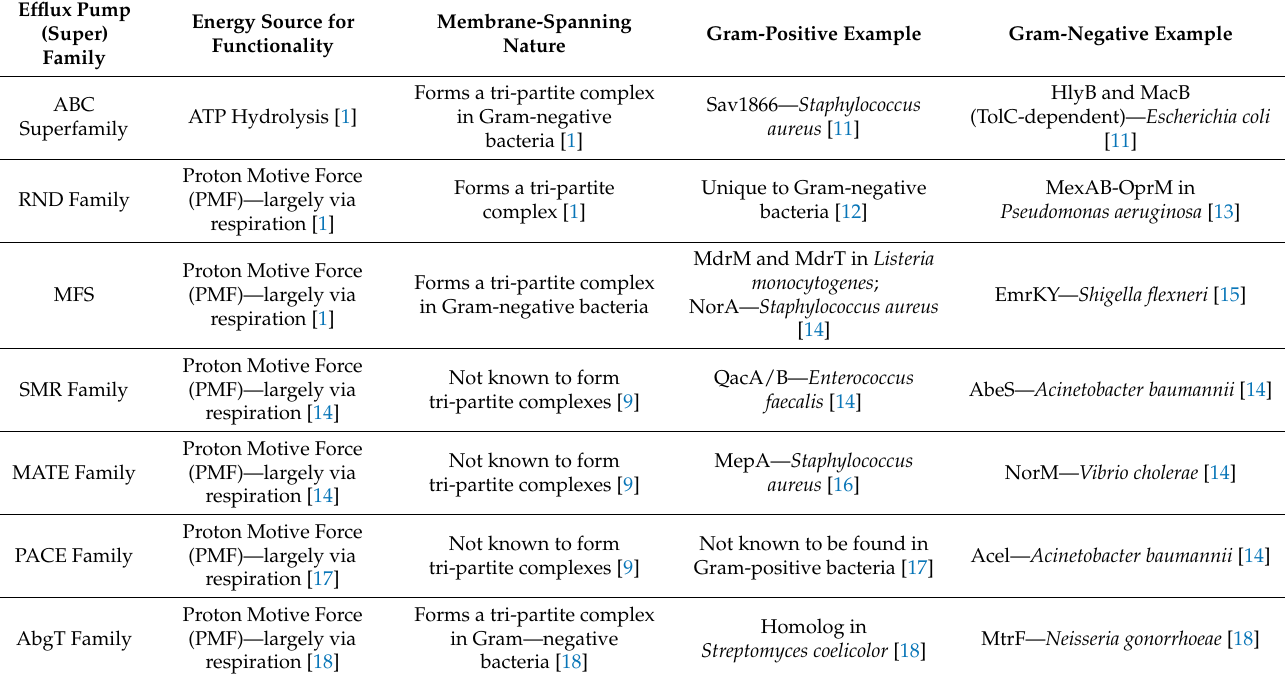
Table 1. The Major (Super)Families of Efflux Pumps in